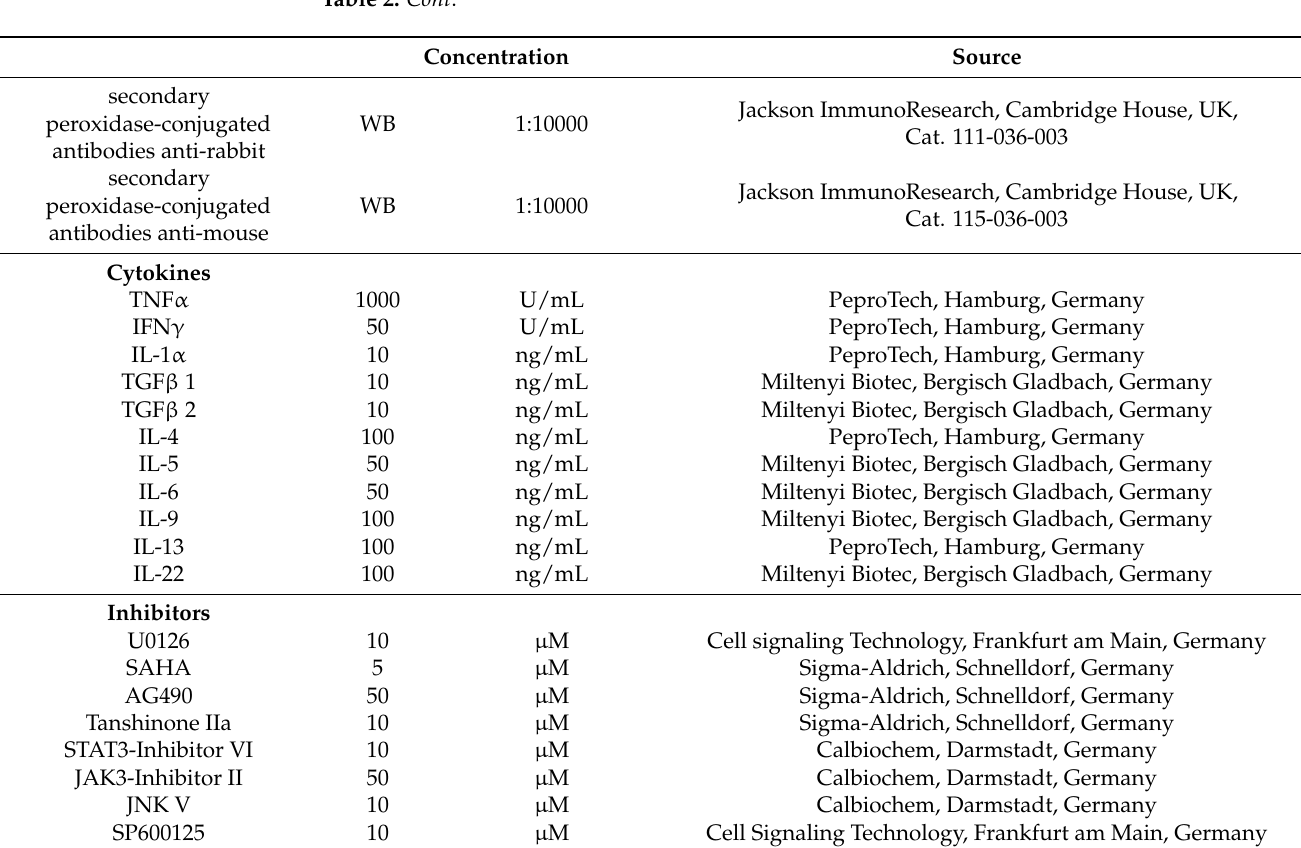
Table 2. Cont . Concentration